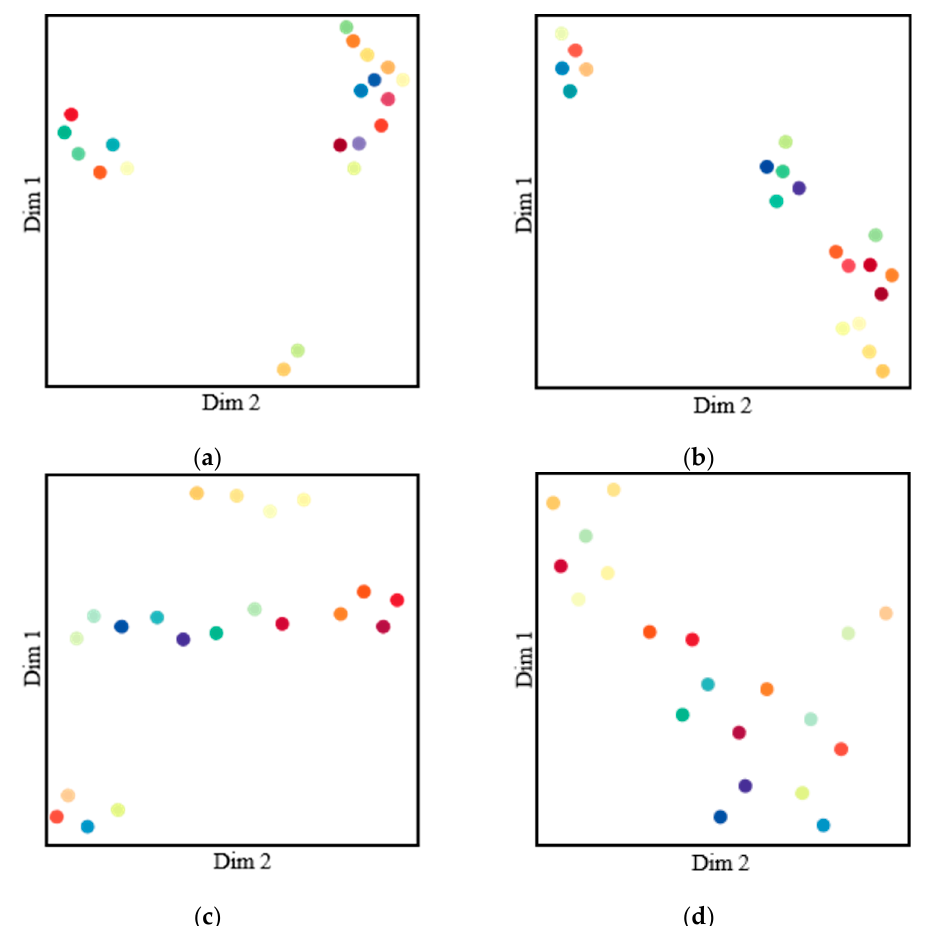
Figure 3. The visualization of class prototypes. ( a – d ) in the figure indicate the corresponding settings according to Table 1. Table 2. Comparison of different settings in the Sample-Selection Algorithm.